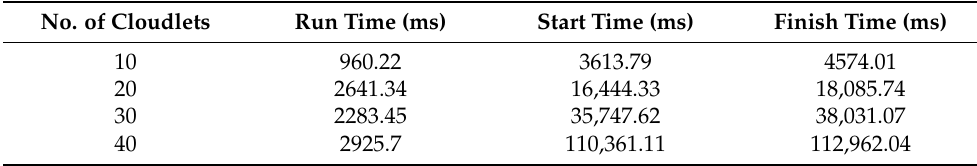
Figure 4. The life cycle of safety messages. Table 7. Total calculated execution time for safety